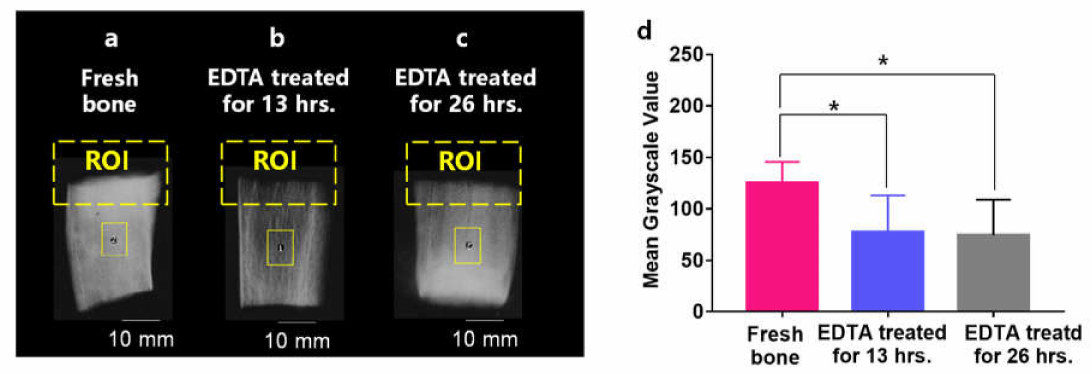
Figure 2. X-ray imaging results for three bone groups. ( a ) The X-ray image of an untreated bone from Group 1. ( b ) The X-ray image of a bone from Group 2 treated with EDTA for 13 hrs. ( c ) The X-ray image of a bone in Group 3 treated with EDTA for 26 h. ( d ) The grayscale value for the three bone groups; * stands for p <